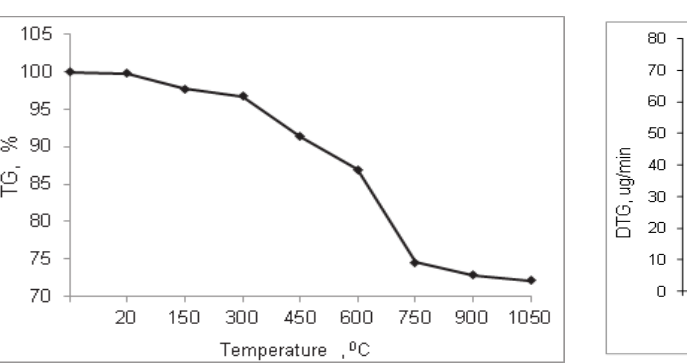
Fig. 7. The curve of thermogravimetric analysis (DTG) of Uvurjargalant’s oil